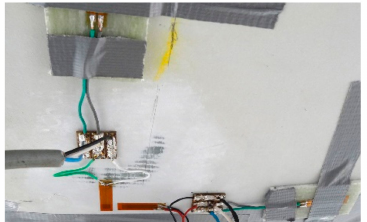
Figure 8. SG sensors mounted to the structure.